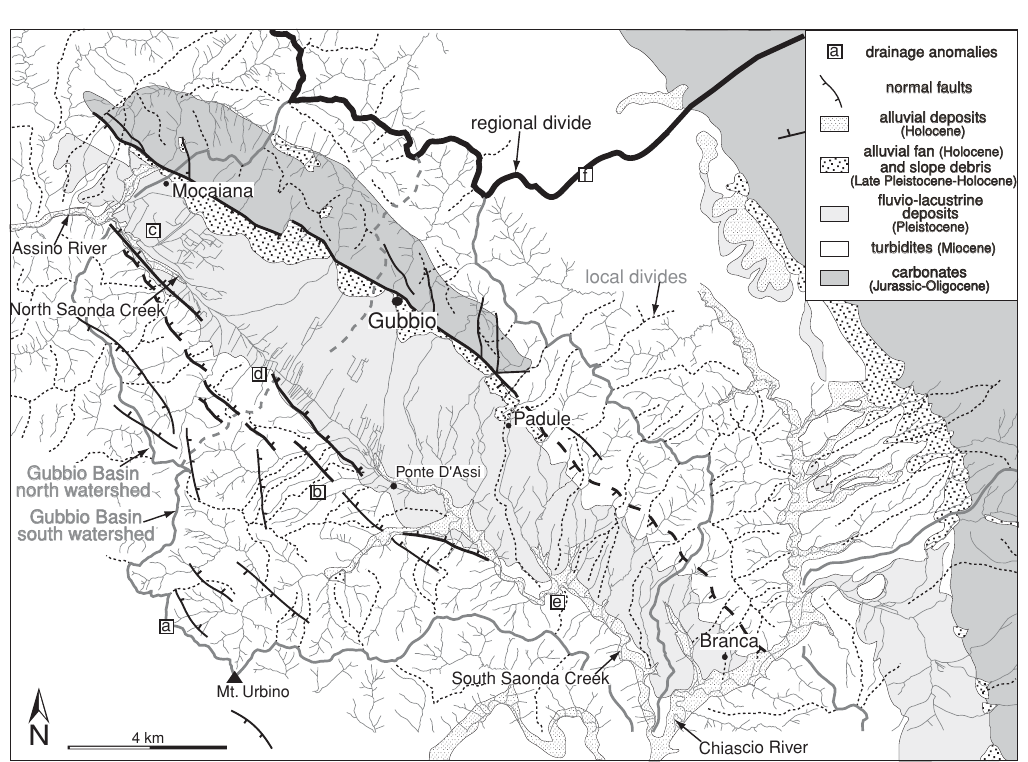
Fig. 9. Drainage map of the Gubbio area. Thick dashed line divides the Gubbio area in two smaller drainage basins: the North and the South Saonda creek basins. Simplified geology is